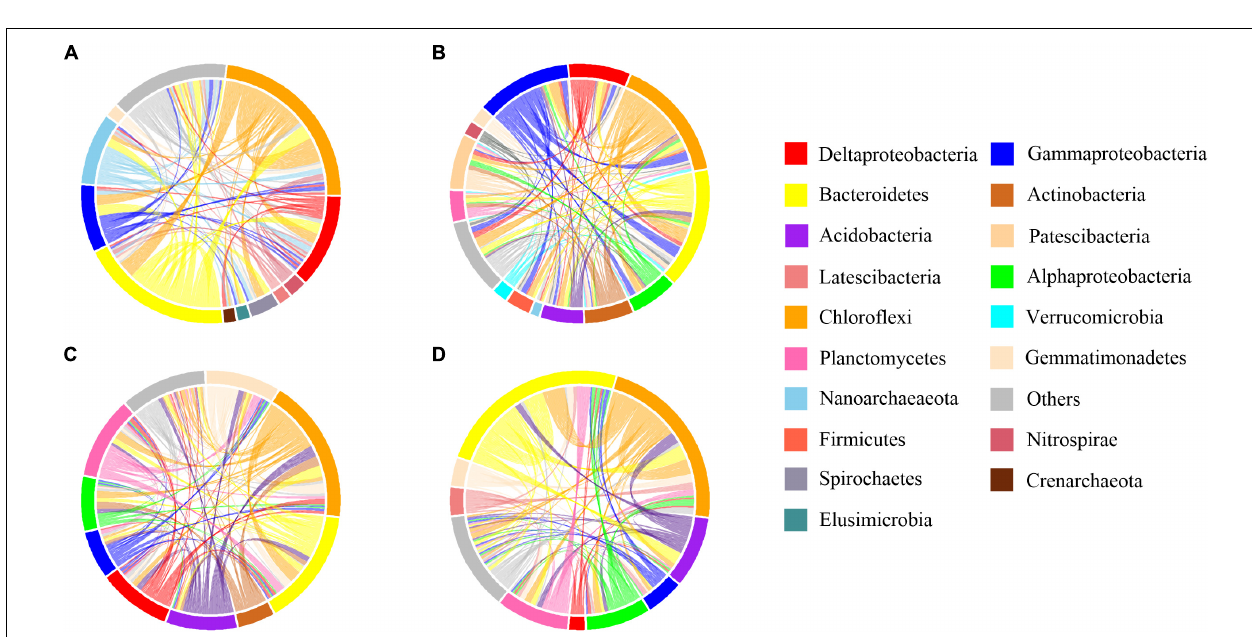
FIGURE 5 | Co-occurrence patterns of abundant bacterial community. The profiles of co-occurrence links among dominant taxa. Connections are colored based on the most dominant taxon (relative abundance above 2%). (A) B sediment of the CON group (B) B sediment of the INV group (C) P sediment of the CON group (D) P sediment of the INV group.